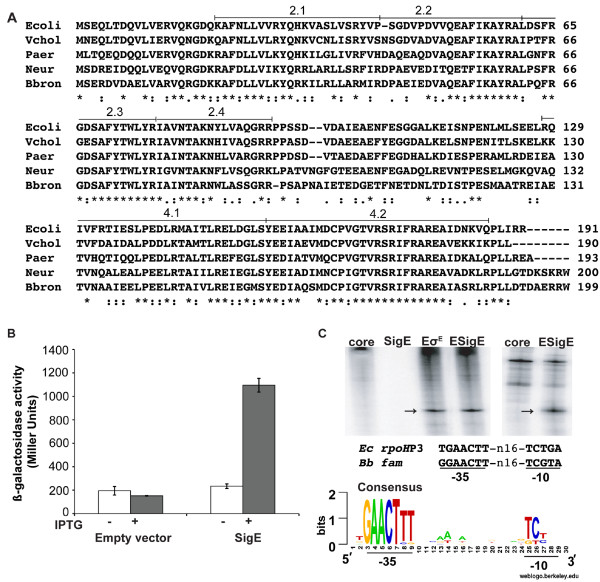
B. bronchiseptica SigE is a functional sigma factor. (A) Amino acid sequence alignment of RpoE- like sigma factors from Escherichia coli (Ecoli), Vibrio cholerae (Vchol), Pseudomonas aeruginosa (Paer), Nitrosomonas europaea (Neur) and B. bronchiseptica (Bbron) using ClustalW2 (EMBL-EBI). Asterisks indicate identity, two dots indicate strong similarity, and one dot indicates weak similarity between amino acid residues. Conserved sigma factor regions 2.1-2.4 and 4.1-4.2
[22] are indicated above the alignment. Regions 2.3, 2.4, and 4.2 are responsible for promoter recognition
[22]. (B) β-galactosidase activity from the E. coli rpoHP3-lacZ reporter increases when B. bronchiseptica sigE expression is induced from plasmid pSEB006 in strain SEA5005 by the addition of IPTG. No increase is seen upon IPTG addition to the control strain, SEA008, containing the empty vector. The observed difference in the amount of β-galactosidase activity between the two strains in the presence of IPTG is statistically significant (P value <0.001) (C) In vitro transcription from a supercoiled plasmid template containing the E. coli σE-dependent rpoHP3 promoter with E. coli core RNA polymerase (core), SigE alone, EσE, and ESigE (left panel). In vitro transcription from a linear template containing the promoter region of B. bronchiseptica fam, with E. coli core RNAP alone (core), or ESigE (right panel). Arrows indicate transcripts from the rpoHP3 and fam promoters. Below, an alignment of the E. coli rpoHP3 and B. bronchiseptica fam promoter sequences and a sequence logo showing the consensus promoter for RpoE-like (ECF02) sigma factors from Staron et al.
[24].